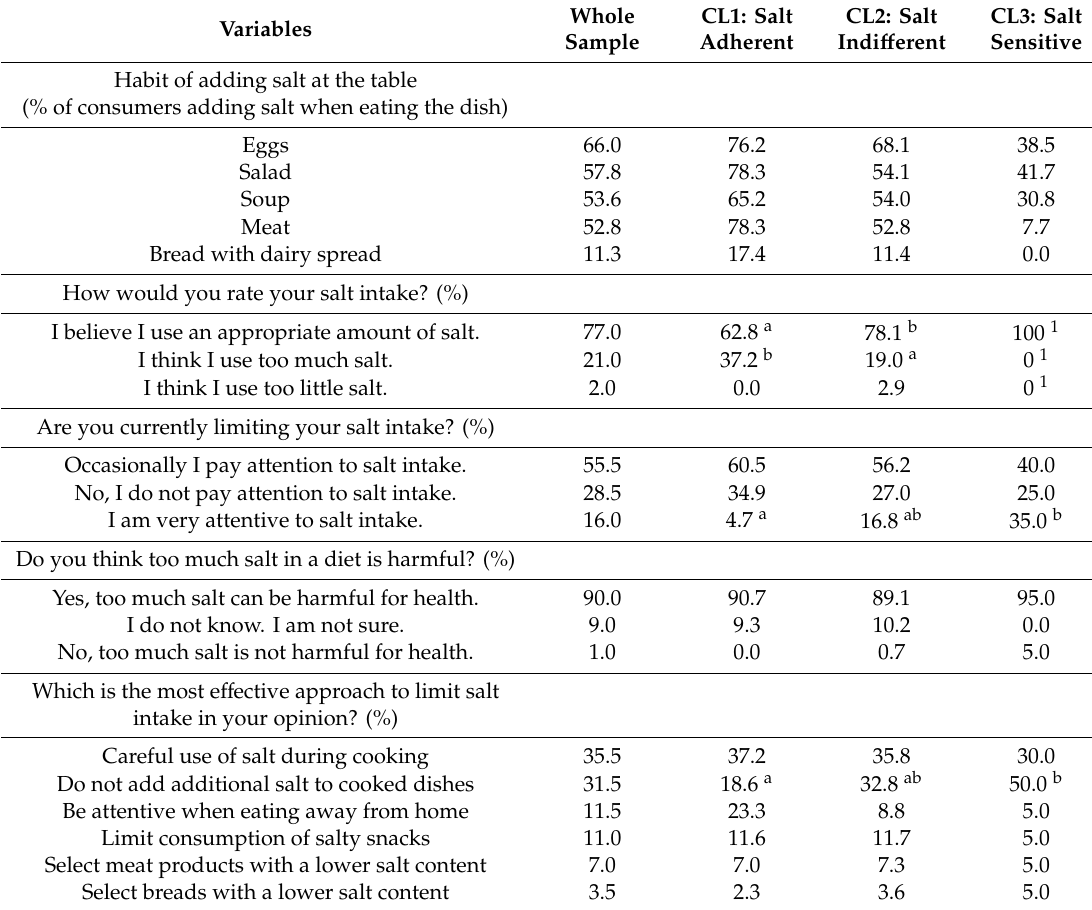
Table 9. Salt intake-related behaviour of the sample and the three clusters ( n = 200).